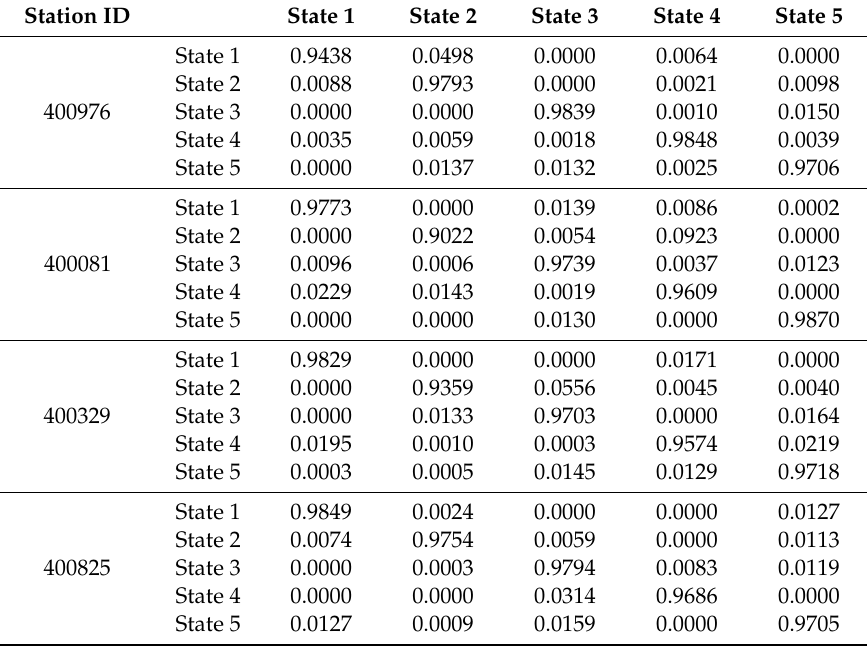
Table 3. Determined A in four regime identification